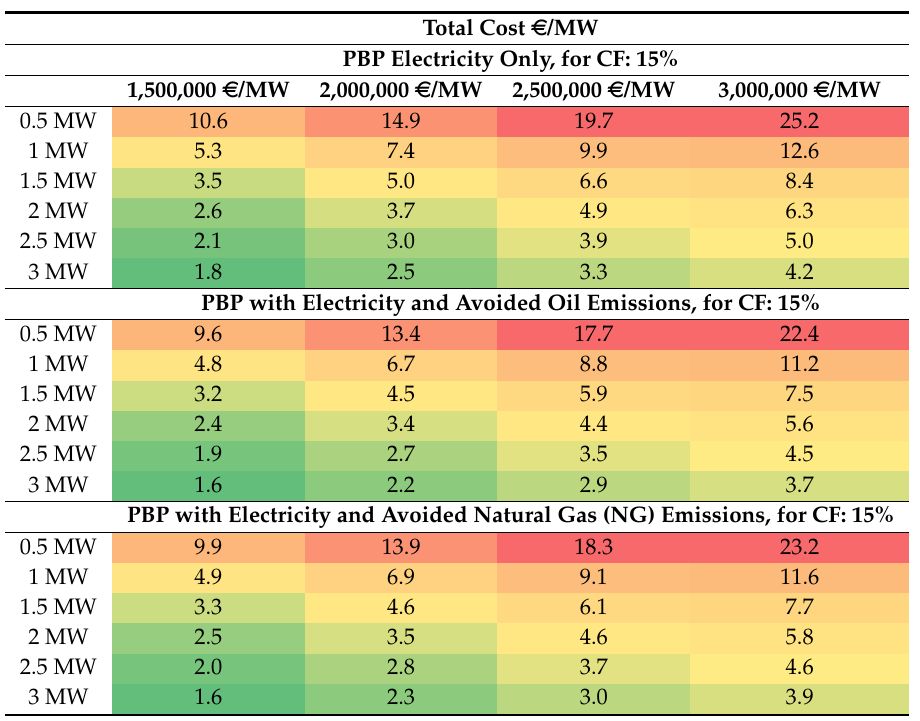
Table 4. PBP for different scenarios, quantifying the avoided emissions as an added revenue stream for an Genoa optimised OWC, for a adapted WEC with increased performance